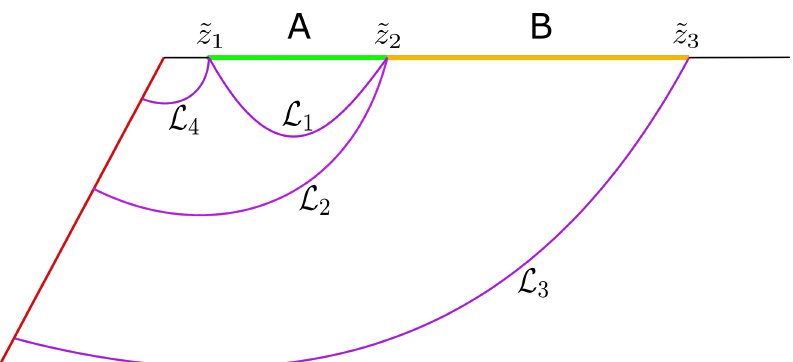
Figure 22. Geodesics contributing to the holographic entanglement negativity of adjacent intervals in